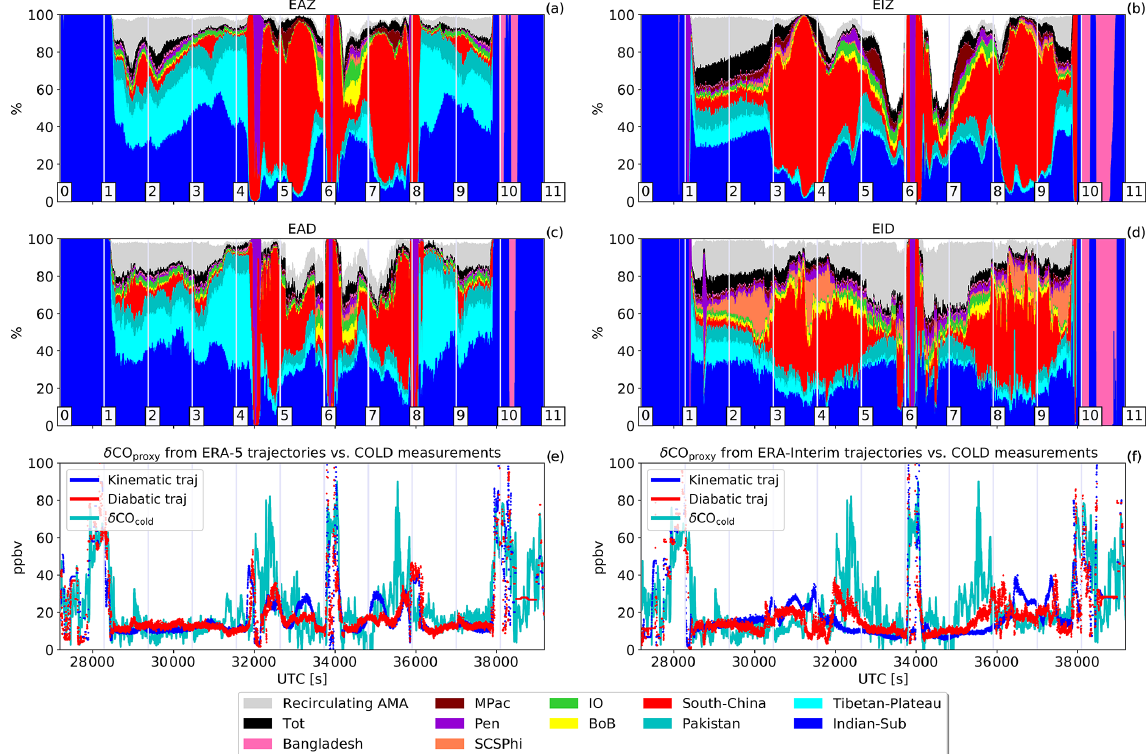
Figure 5. Convective-source contributions in the ERA5 (left column) and ERA-Interim (right column) computations along the flight time of F6 (6 August 2017). The thickness of each coloured layer in (a) – (d) represents the percentage of contribution of the region associated with the colour code shown in Fig. 3. The grey layer indicates the percentage of parcels recirculating inside the Asian monsoon anticyclone without hitting convection. The thickness of the black layer indicates the percentage of contribution from sources different from the ones identified in Fig. 3. The remaining white layer represents the percentage of parcels that exited the boundaries of the domain before encountering any convective cloud. Panels (e) and (f) show the time series of the CO anomalies δ CO cold (in green) measured by the COLD2 instruments compared to the artificial CO enhancement δ CO proxy simulated from both the kinematic (blue) and diabatic (red) computations. Numbers on the panel punctuate the flight path on equally spaced time intervals, corresponding to the position of the flight, as shown in Fig.